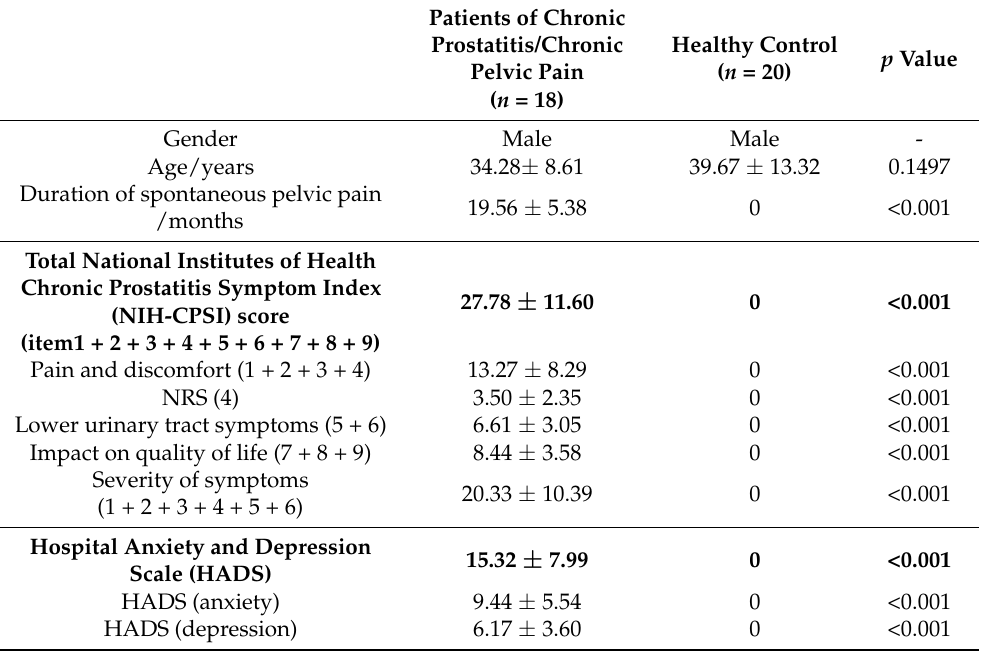
Table 1. The Characteristics of